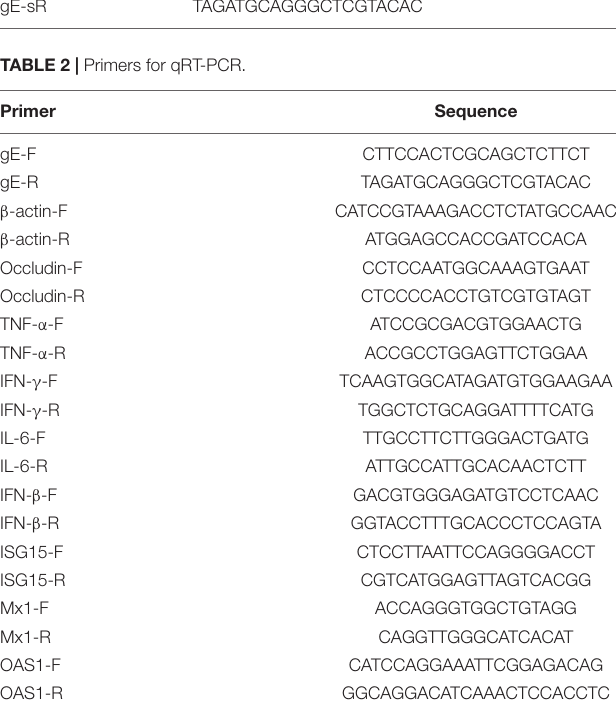
TABLE 2 | Primers for